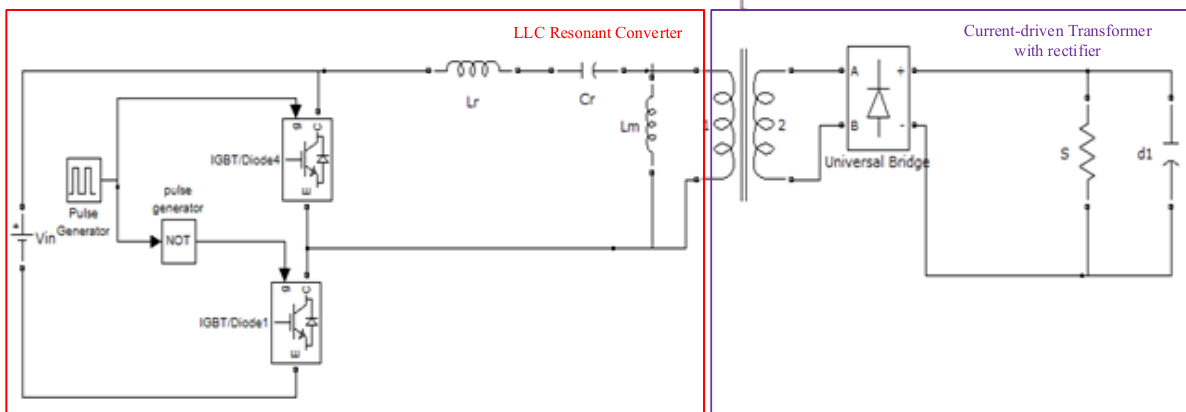
Fig. 2 Simulink block diagram of current mode control of LLC resonant